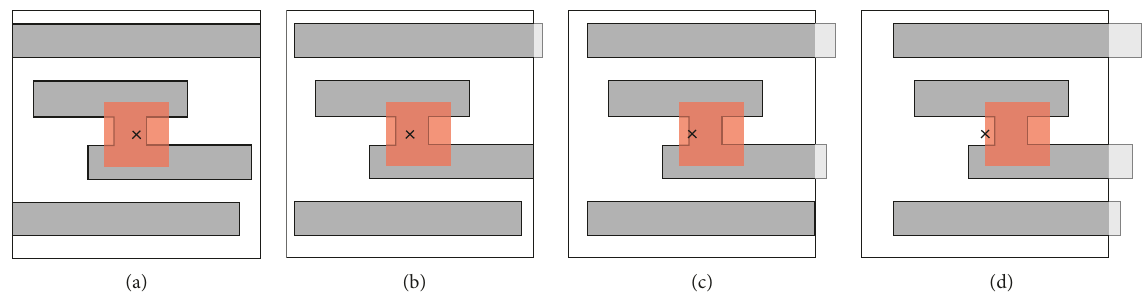
Figure 4: A sample set of configurations of a clip (with shifting)